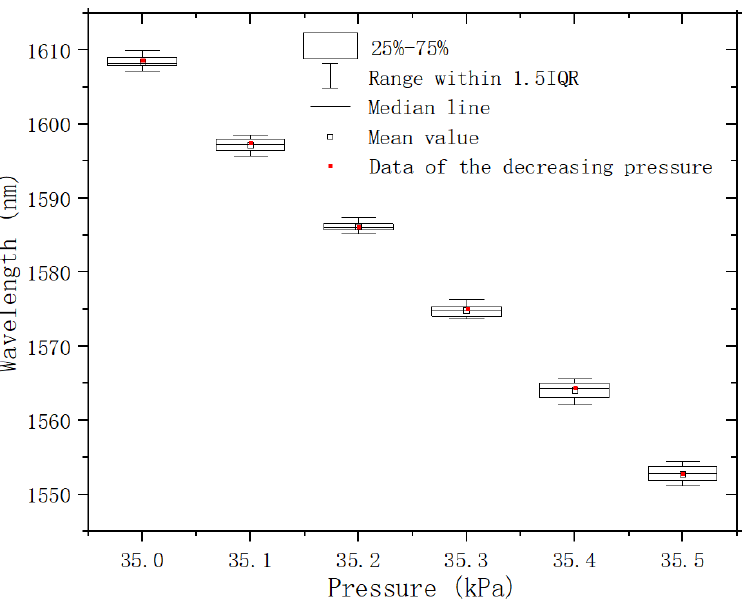
Figure 8. Repeatability test of the pressure sensor.